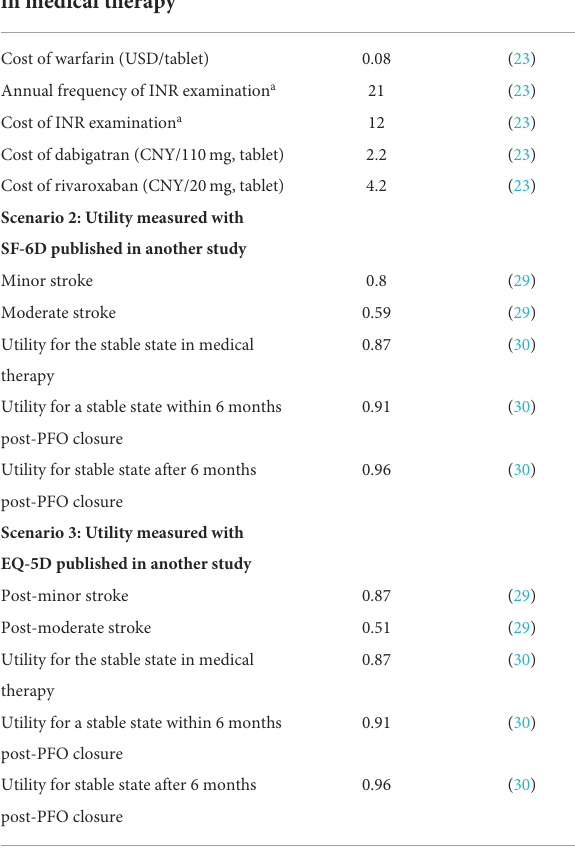
TABLE 2 Input parameters in the scenario